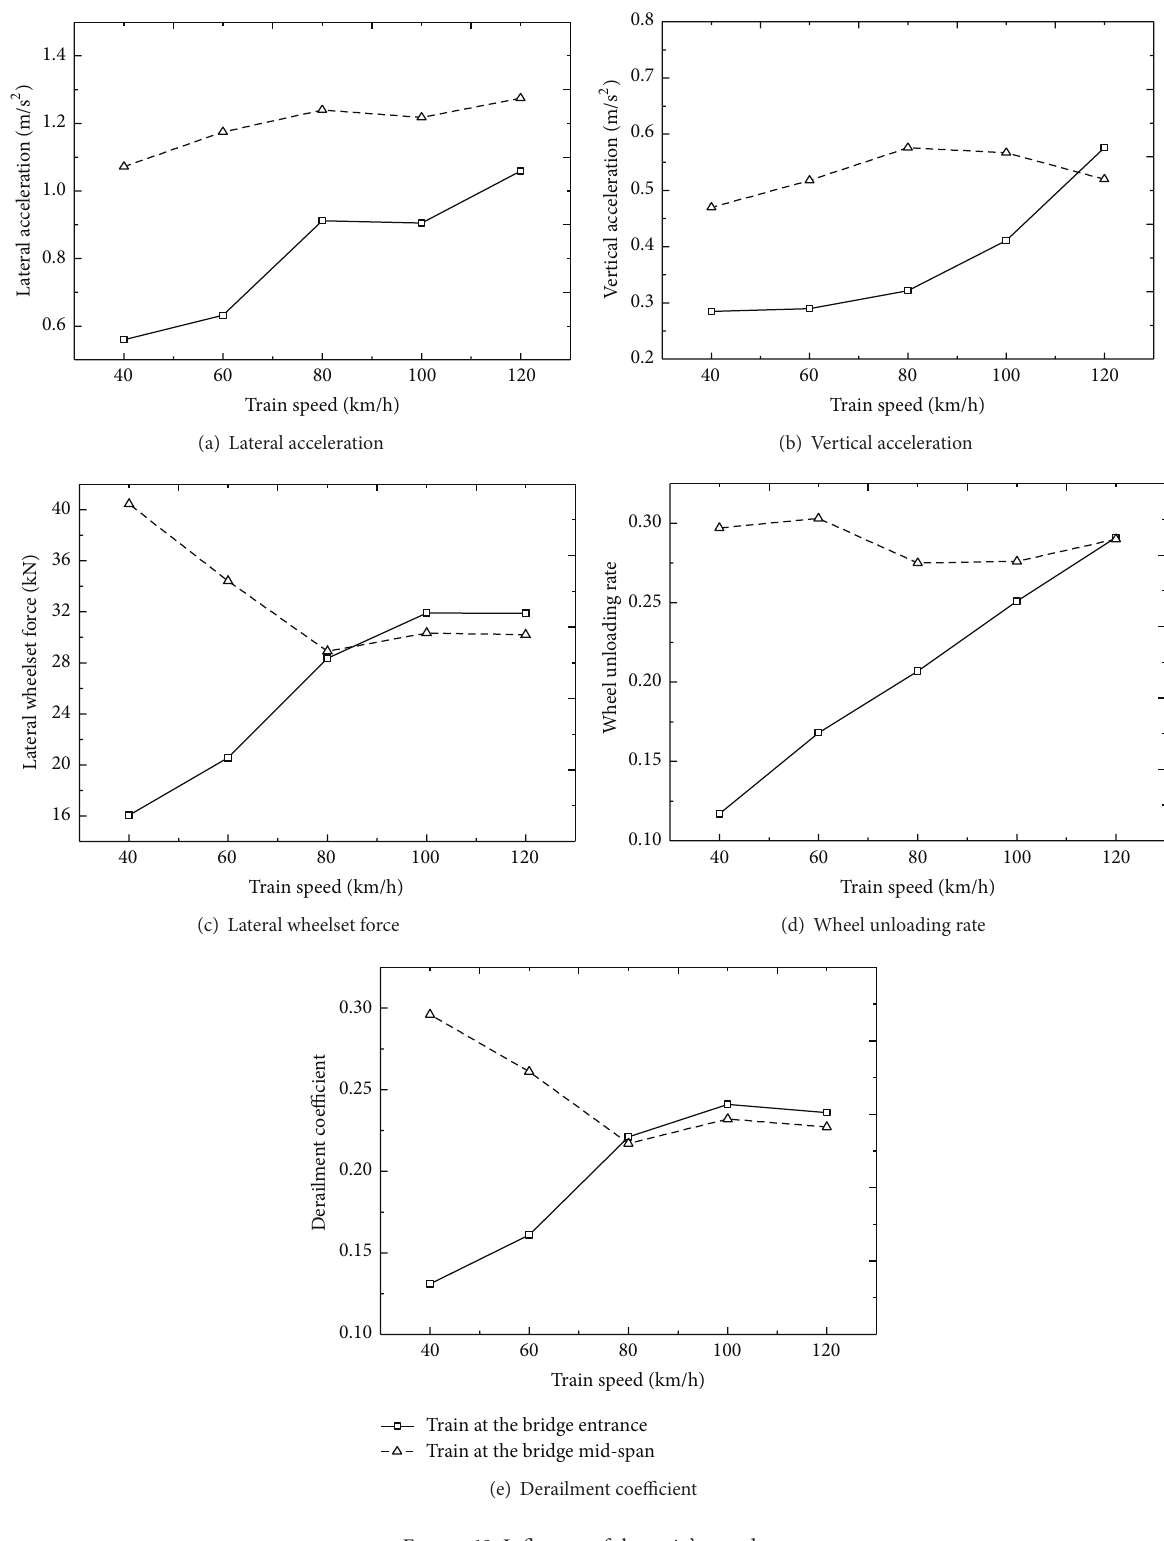
Figure 19: Influence of the train’s